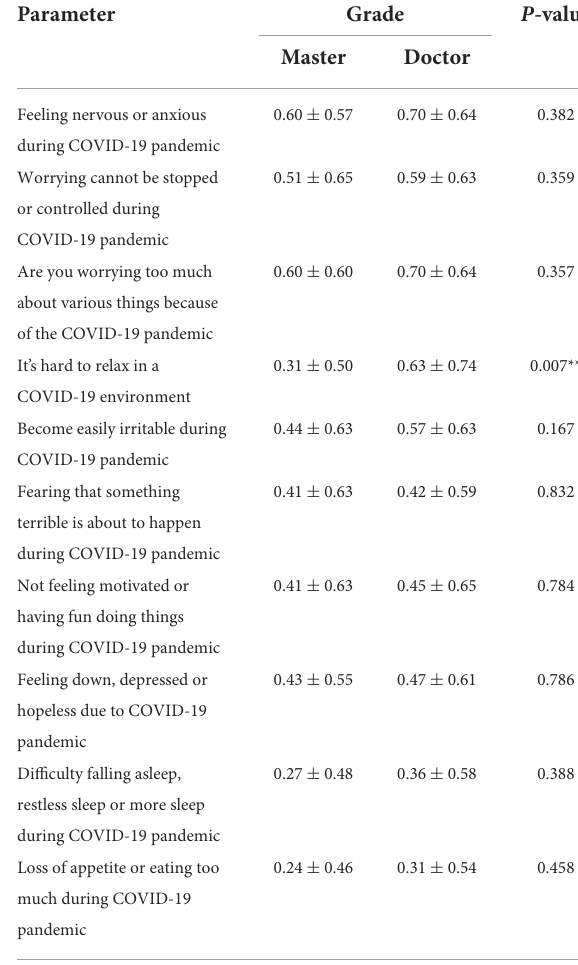
TABLE 6 Comparison of the mental health taken by gender. TABLE 7 Comparison of the mental health taken by